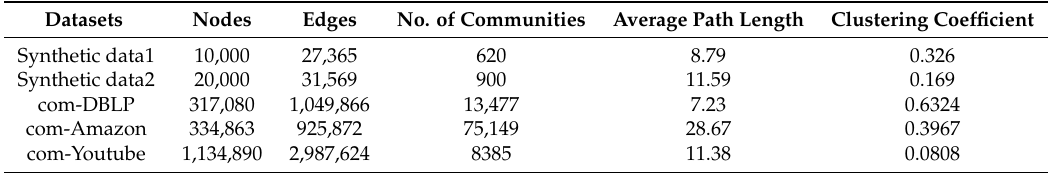
Table 2. Datasets used for